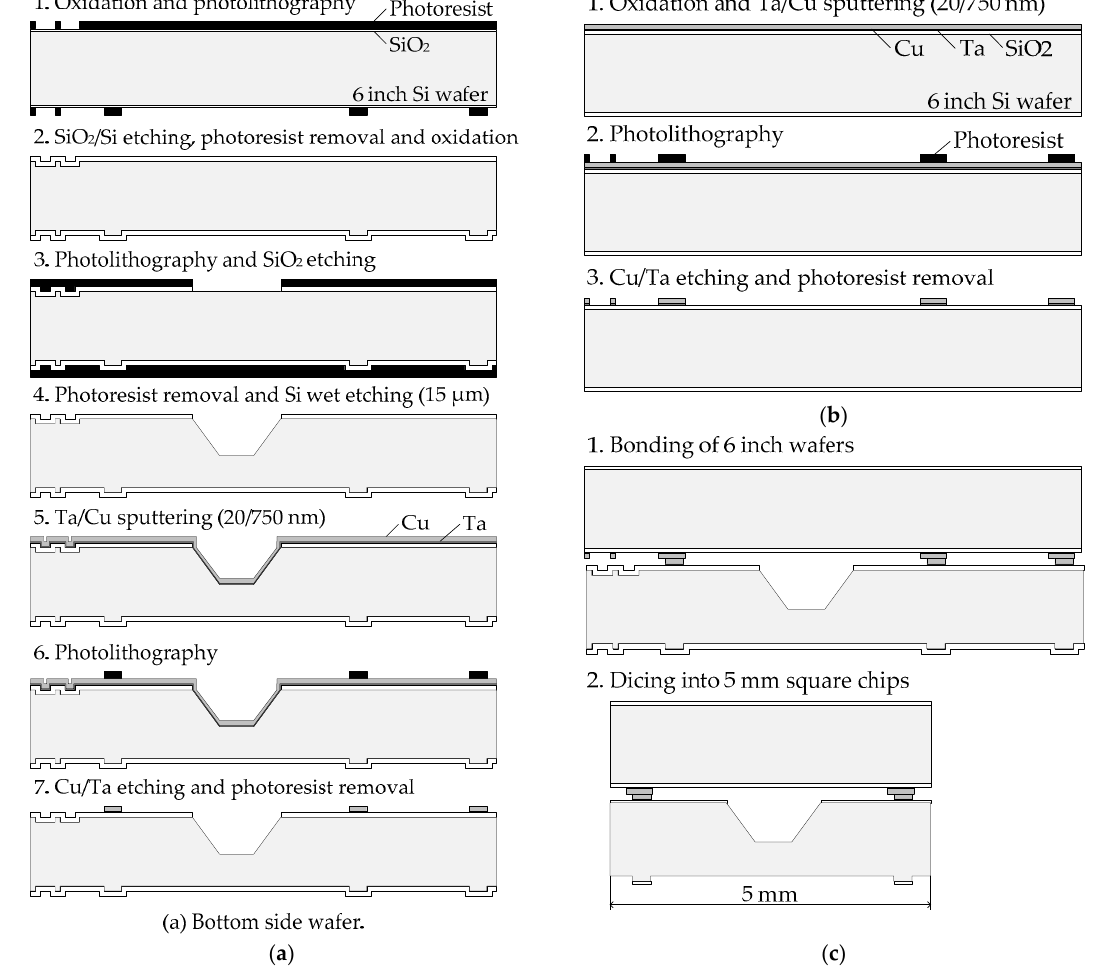
Figure 2. Fabrication process of the sample wafers. ( a ) Bottom side wafer; ( b ) top side wafer; ( c ) bonding and dicing process.